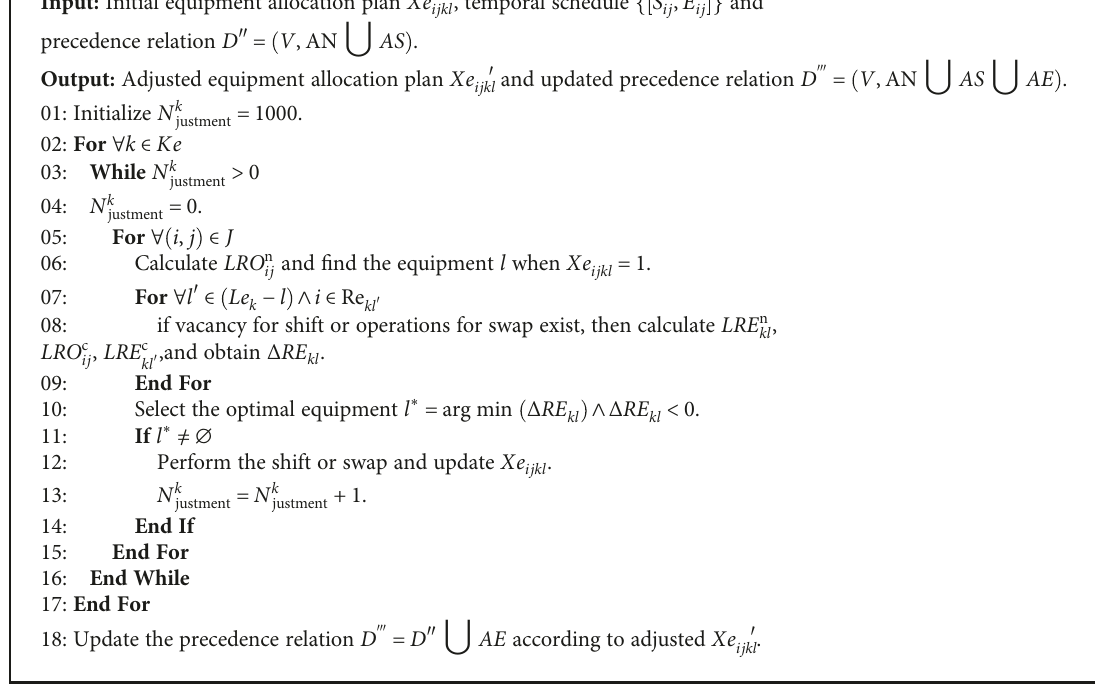
Algorithm 3: Robust equipment allocation adjustment